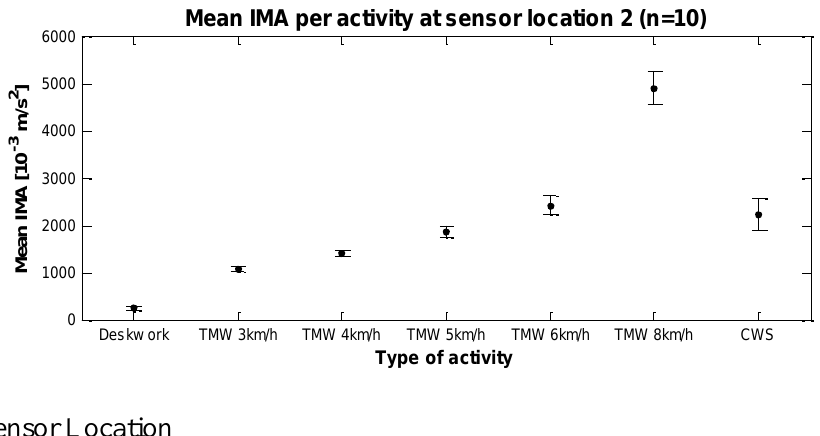
Figure 6. Error bars with 95% confidence intervals for mean IMA values per activity, at sensor location 2 (n = 10); TMW = treadmill walking; CWS = comfortable walking speed.